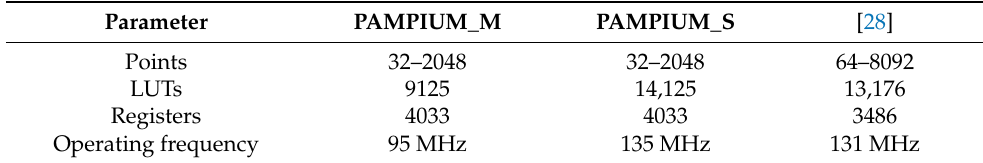
Table 5. FPGA implementation results for the FFT algorithm.